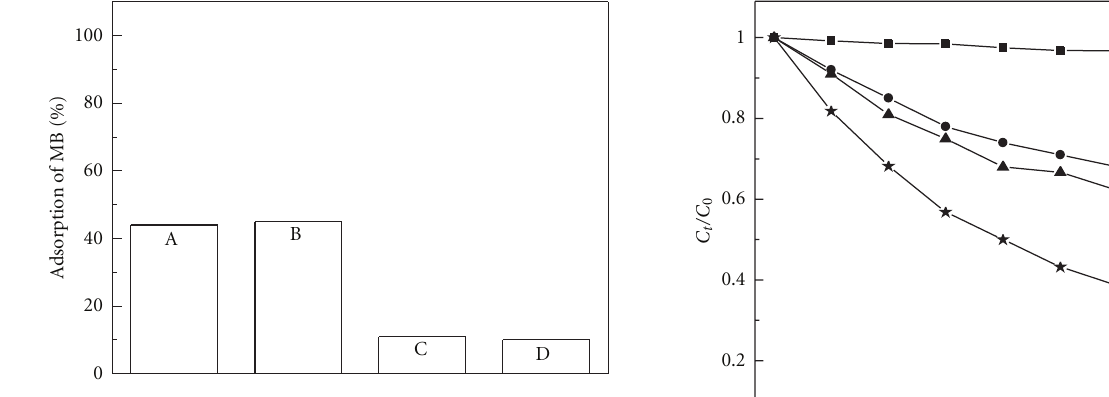
N-TiO 2 , C-TiO 2 (UV), and C-TiO 2 (200), respectively.